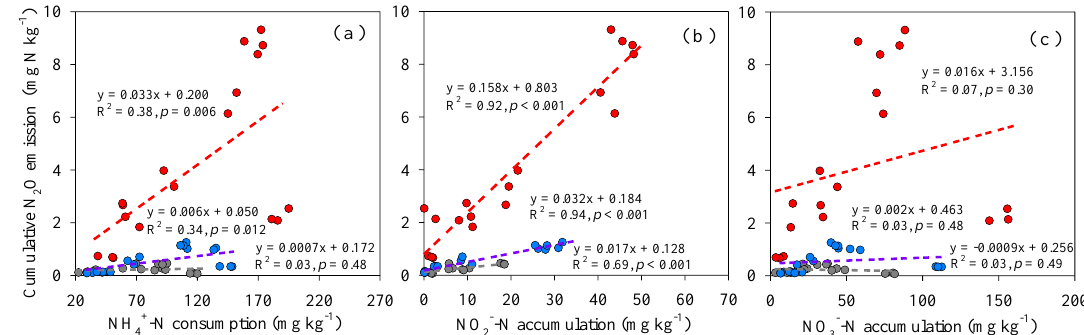
Figure 5. Correlation analysis of cumulative N 2 O emissions with NH 4 + -N consumption ( a ), NO 2 − -N accumulation ( b ) and NO 3 − -N accumulation ( c ). Gray, blue and red dots were from 50% θ fc 75% θ fc and 100% θ fc respectively.